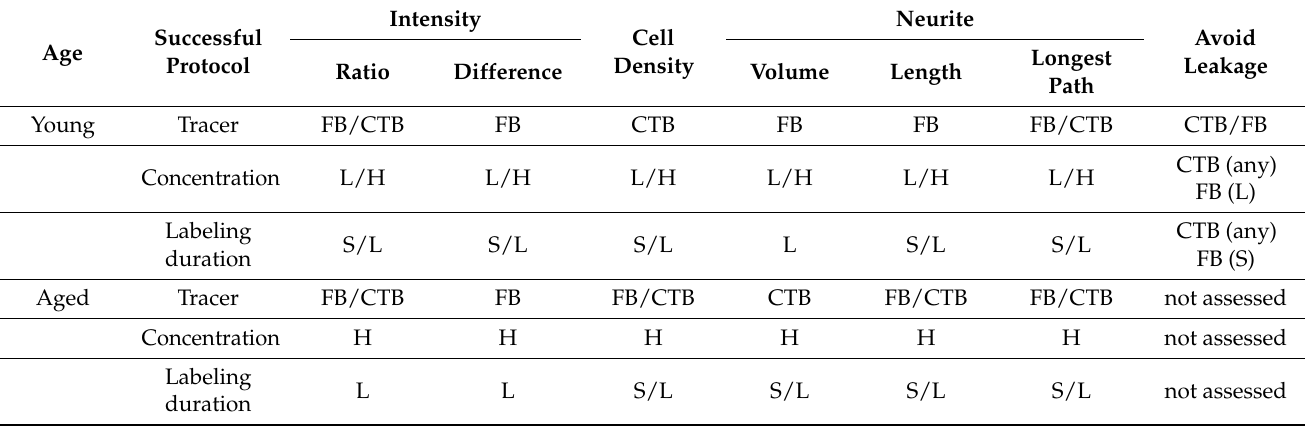
Table 3. Comparison of the tracer protocols. L and H refer to low and high concentrations and S and L refer to short and long labeling durations, respectively.